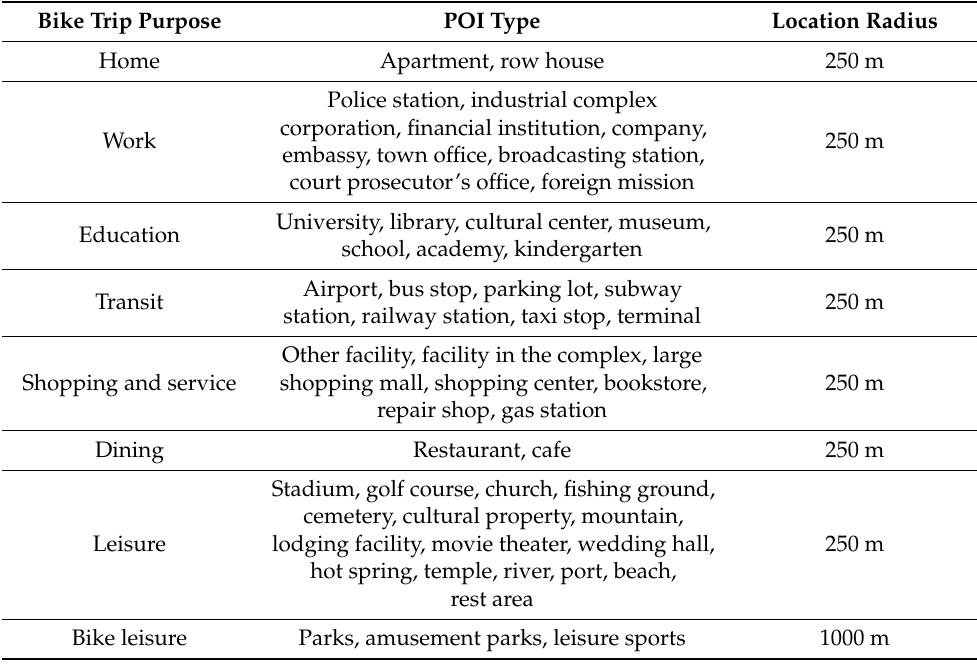
Table 5. Reorganized POI type for inference of bike trip